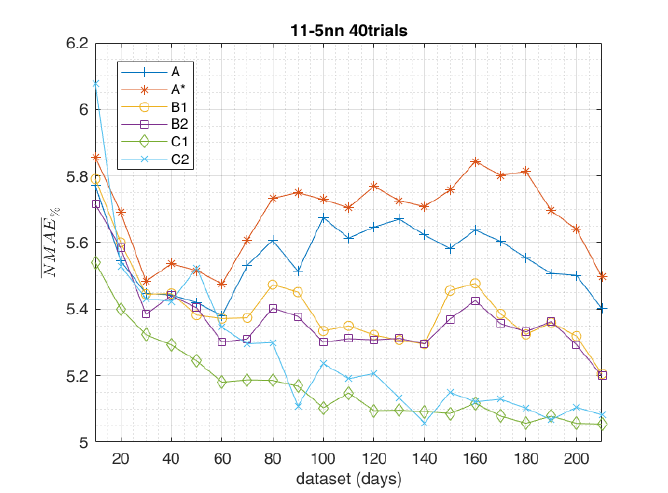
Figure 15. NMAE % as a function of the dataset size.